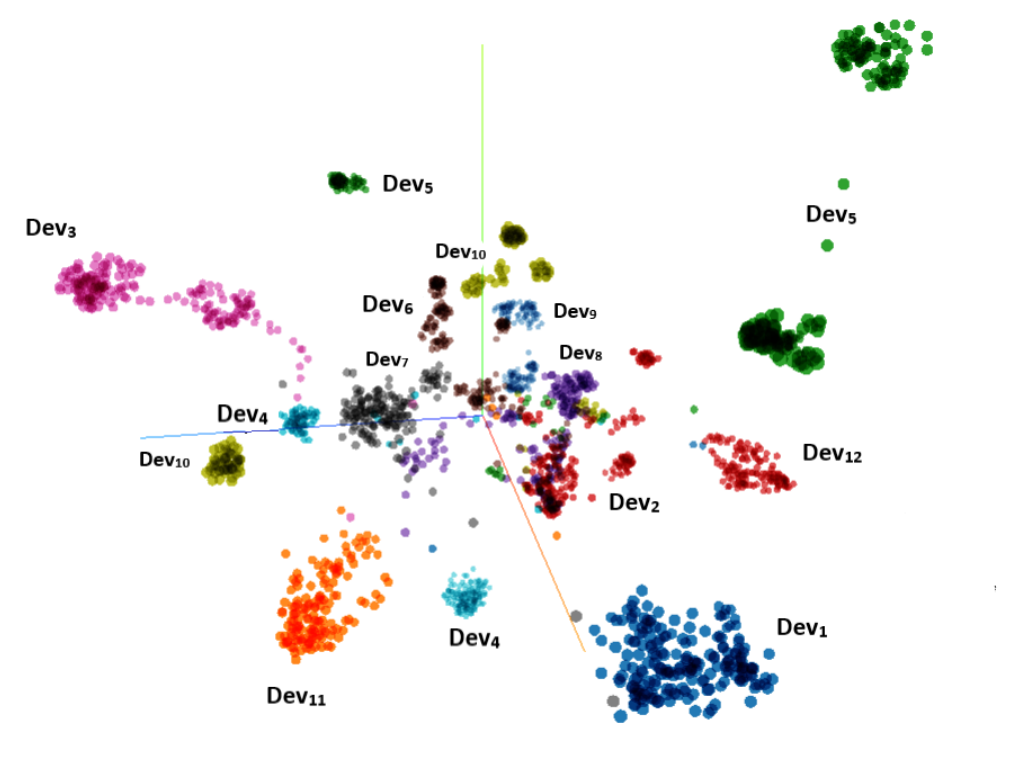
Figure 3. T-SNE visualization for the subset of 12 developers, unigram features and doc2vec vector size of